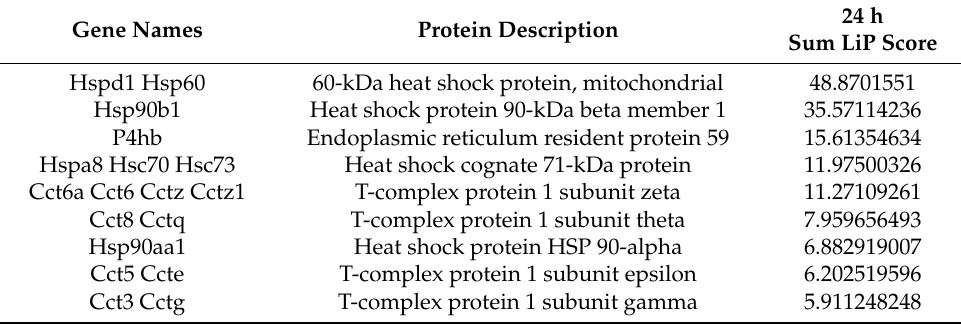
Table 1. Structural changes of protein folding-related genes after macrophage activation for 24